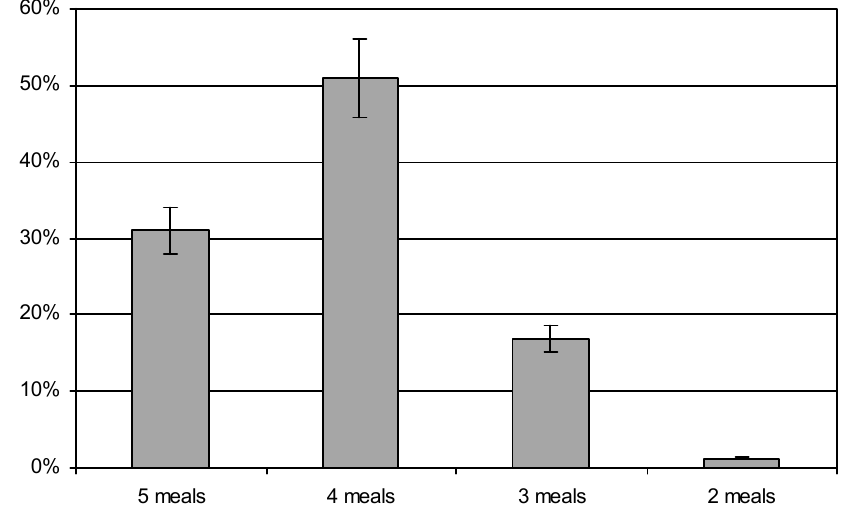
Figure 1. Number of meals eaten during the day eaten by participants.